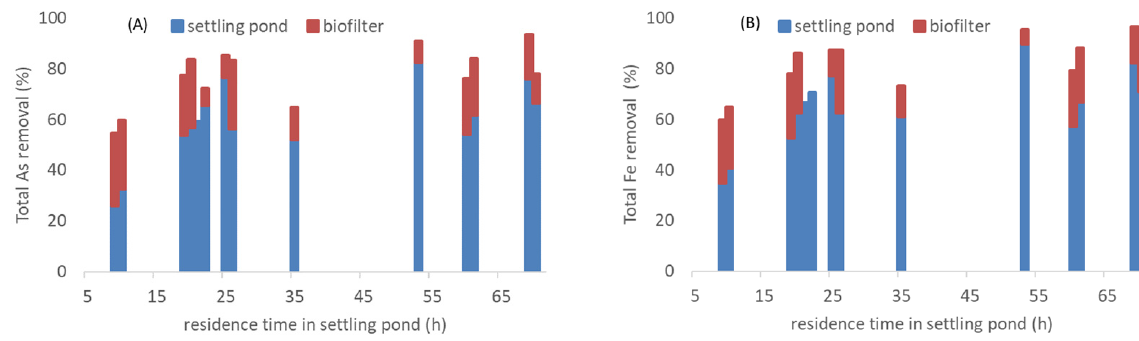
Figure 7. Total As ( A ) and Fe ( B ) removal in the settling pond and in the